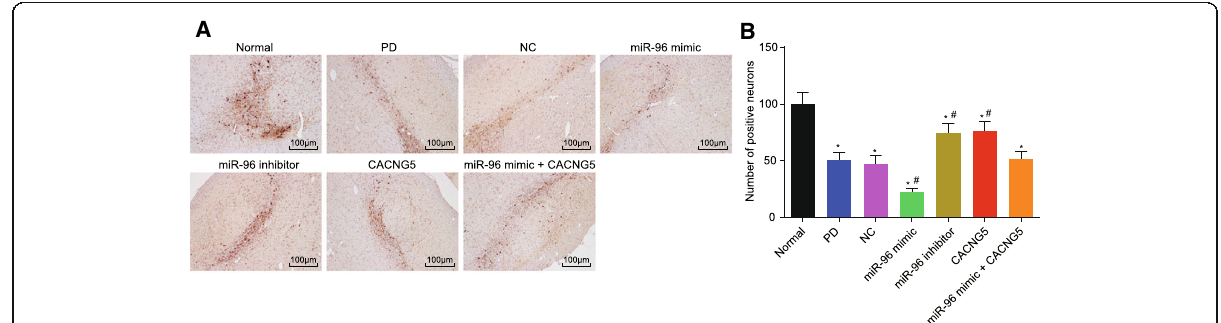
Fig. 4 miR-96 inhibitor increases expression of TH in substantia nigra dopaminergic neuronal tissues (× 100). a TH immunohistochemistry for dopaminergic neuronal tissues among seven groups; b positive TH cells among seven groups under a microscope; * , P < 0.05 compared with the normal group, # , P < 0.05 compared with the PD and NC groups. The test was repeated three times independently, and the one-way ANOVA analysis was used for comparison among multiple groups (n = 10 in each group). TH, tyrosine hydroxylase; miR-96, microRNA-96; CACNG5, calcium voltage-gated channel auxiliary subunit gamma 5; PD, Parkinson ’ disease; NC, negative